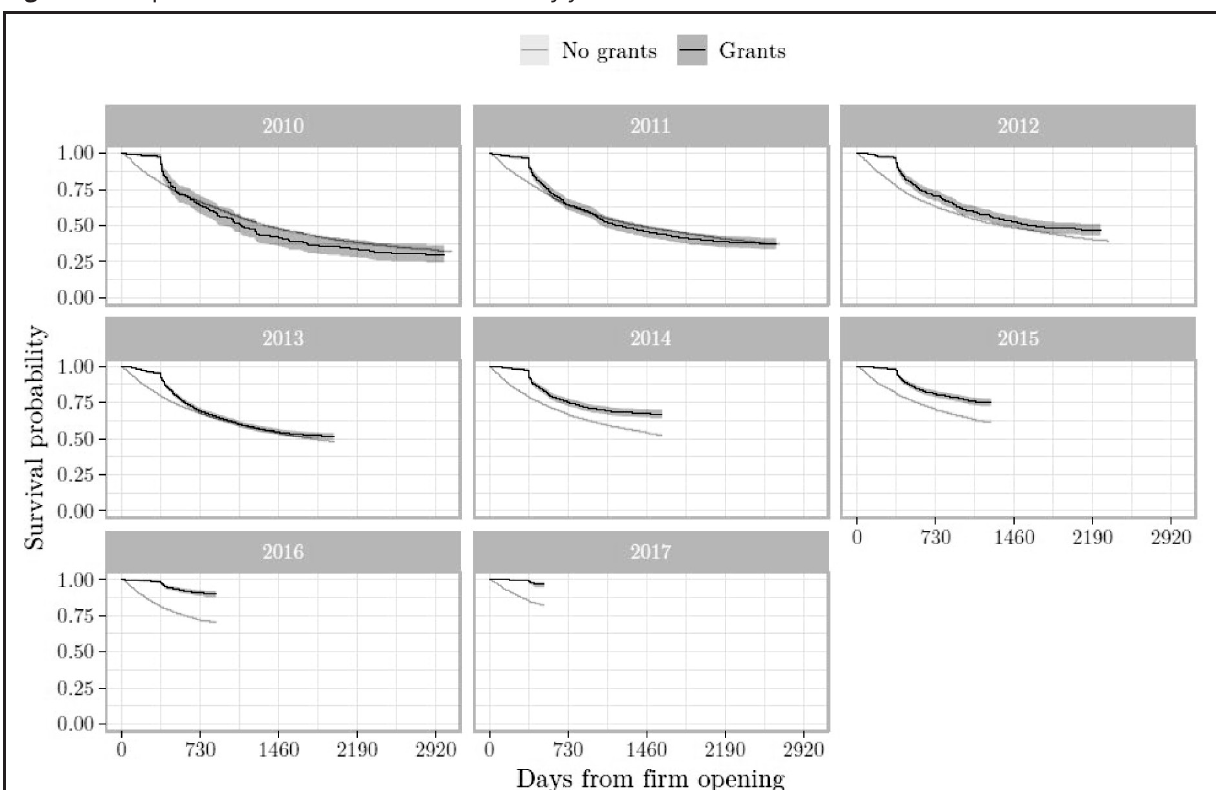
Kaplan–Meier firm survival estimates by